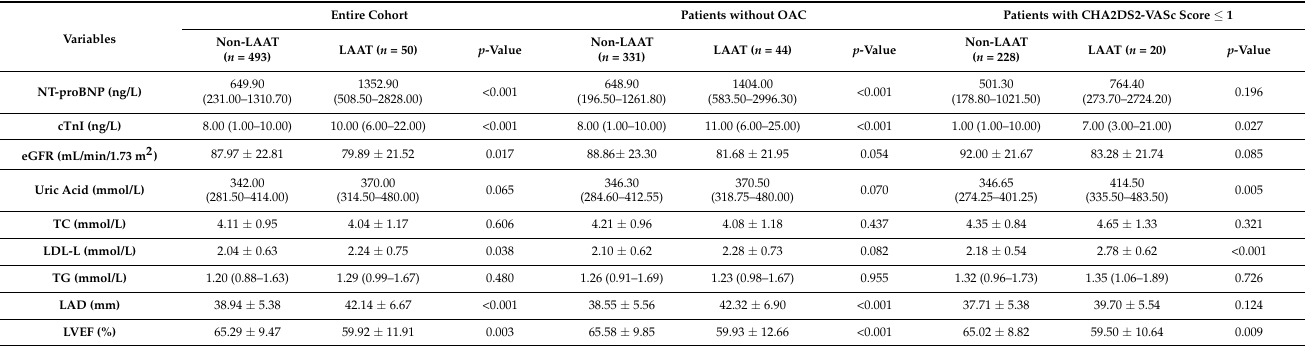
Table 3. Comparison of laboratory serum biomarkers and echocardiographic parameters for non- LAAT and LAAT groups in the entire cohort, and patients with CHA2DS2-VASc score ≤ 1 (female excluded) and patients without OAC,